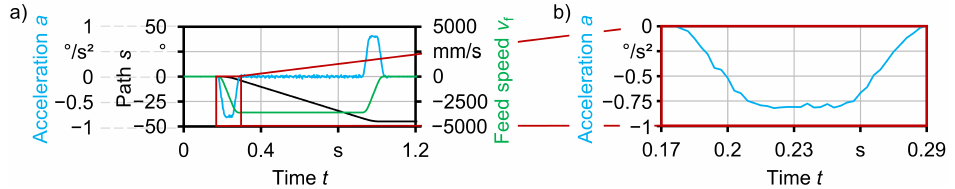
Figure 3. ( a ) Positioning from C (cid:48) = 0° to C (cid:48) = −45° with ∆ v f = 3600°/min and ( b ) linear increase of the acceleration due to a constant